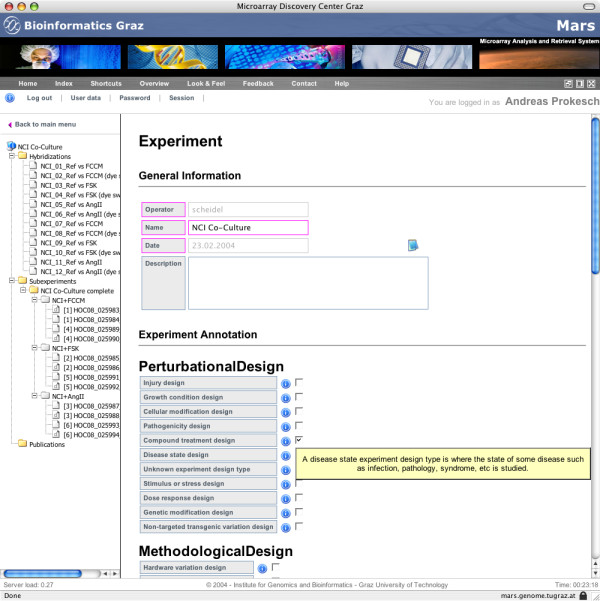
Experiment annotation. Web interface to define microarray experiments according to the MGED Ontology.